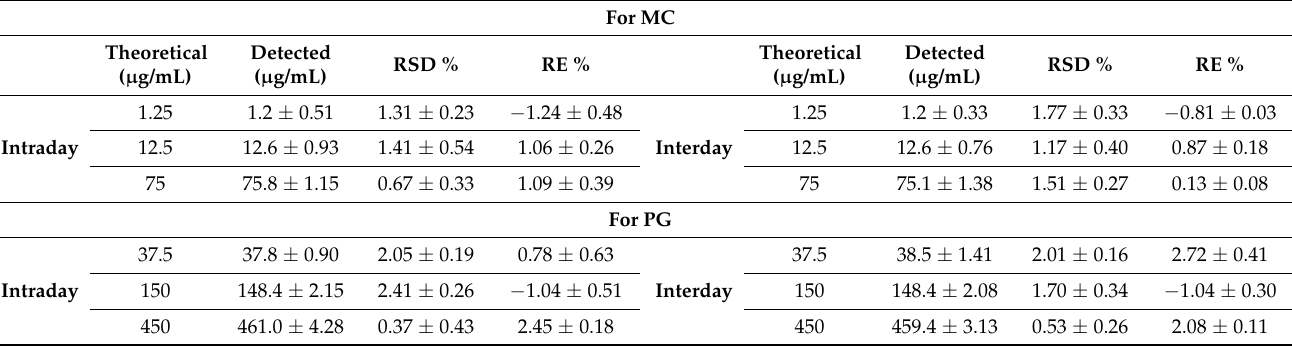
Figure 3. Blank OTFs ( left ), PG and MC included OTF ( right